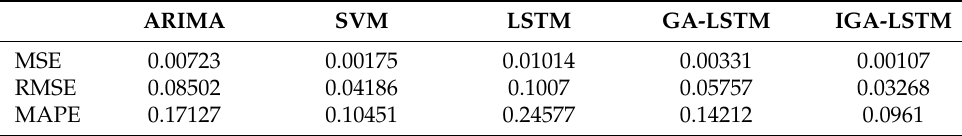
Table 6. Linear low-density polyethylene results.